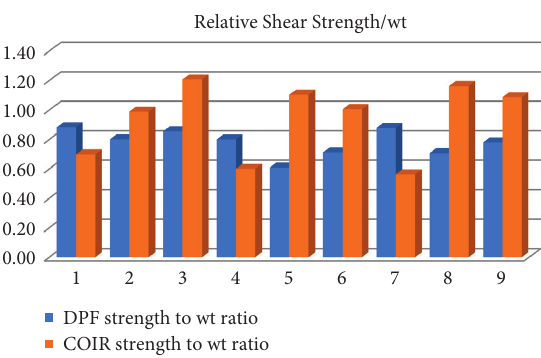
Figure 14: Relative shear strength/weight ratios of